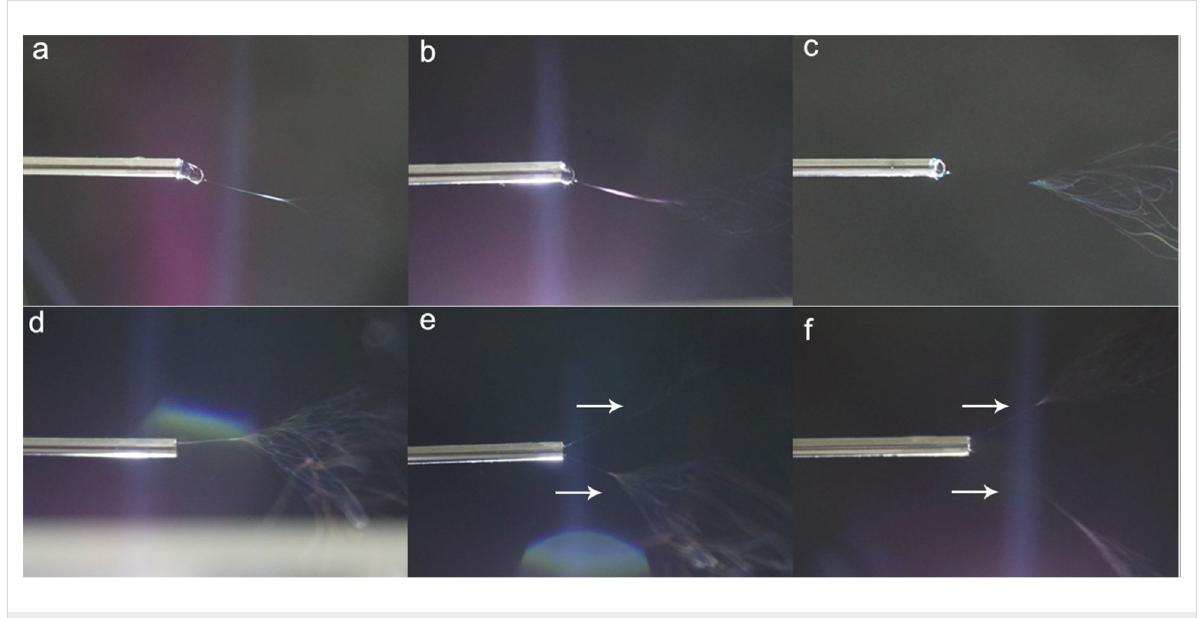
Figure 1: Optical images of jet evolution in spinning process at different voltage values. (a) 6 kV, (b) 10 kV, (c) 15 kV, (d) 20 kV, (e) 25 kV, and (f) 30 kV (the inner diameter of the spinneret is 0.8 mm, the outer diameter is 1.2 mm). Figure 1 was adapted from [23] (© 2019 Z. Liu et al., published by Springer Open, distributed under the terms of the Creative Commons Attribution 4.0 International